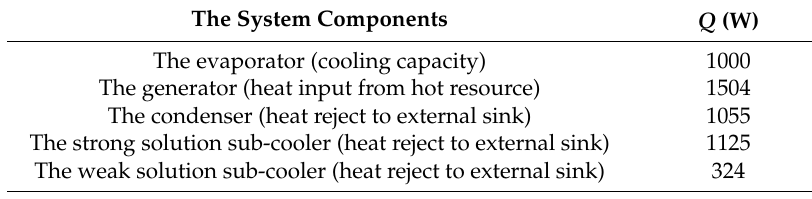
Table 2. The heat transfer in each component and COP of the LiBr/water absorption refrigeration system equipped with an adiabatic